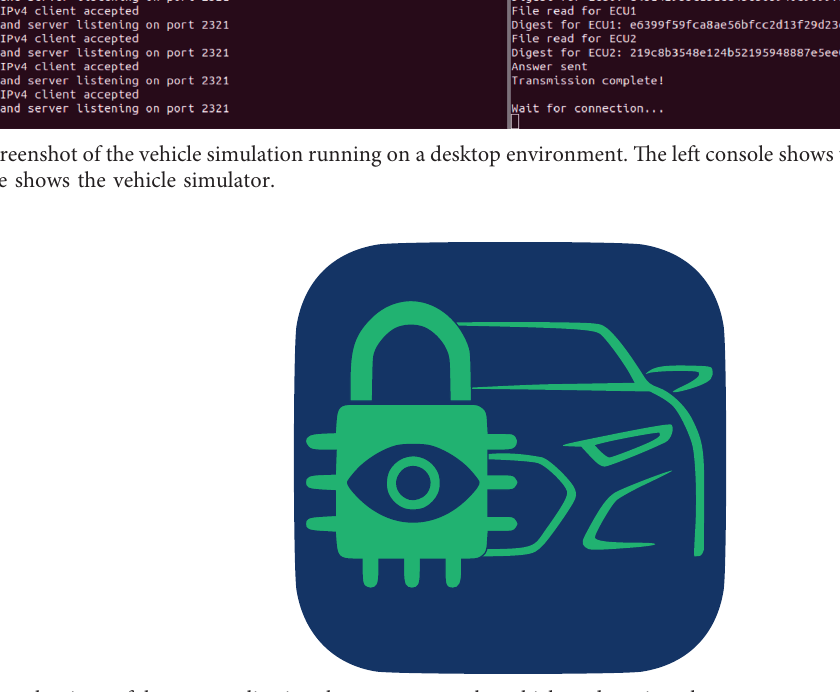
Figure 9: Launcher icon of the user application that connects to the vehicle and receives the measurements. It then manages and compares the measurements.